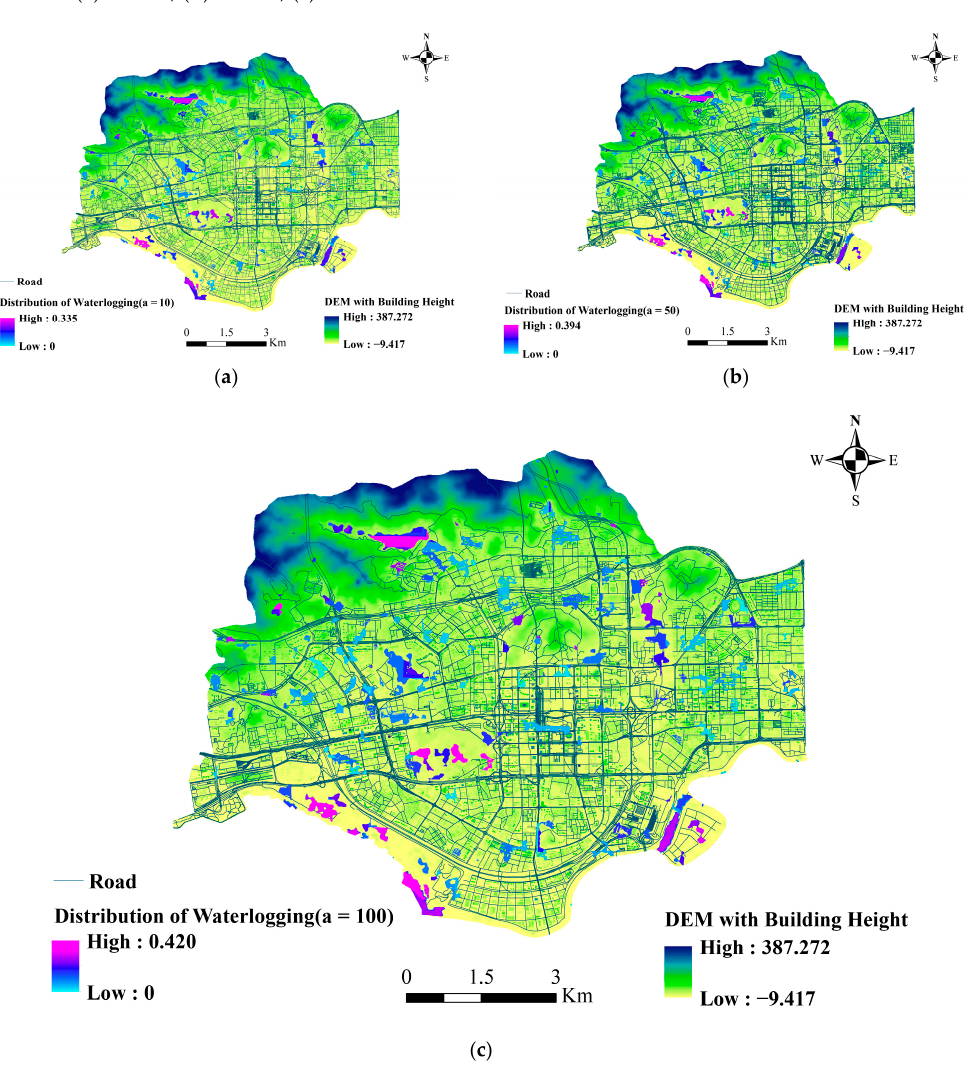
fall models. ( a ): a = 10; ( b ): a = 50; ( c ): a = 100. models. ( a ): a = 10; ( b ): a = 50; ( c ): a = 100.